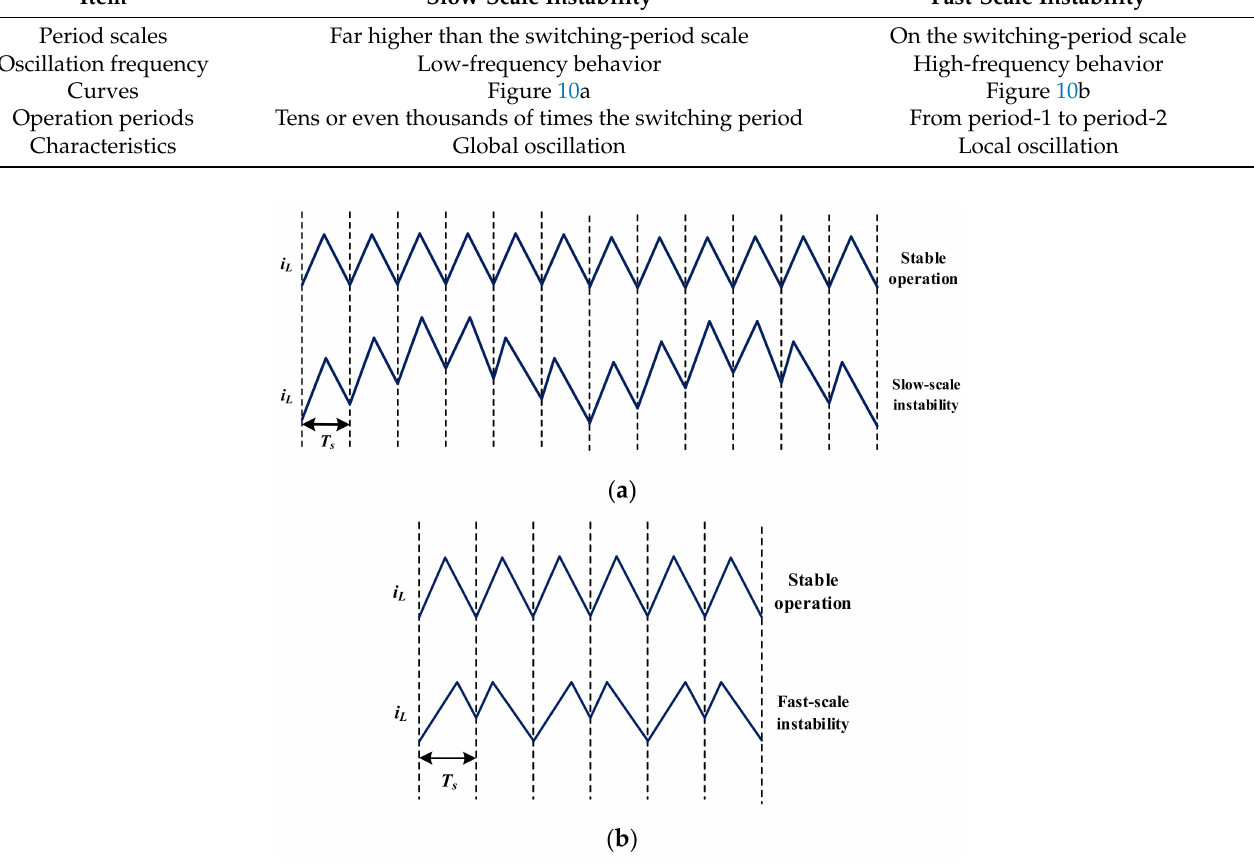
Figure 10. Characteristic curve of the instabilities. ( a ) Slow-scale instability and ( b ) fast-scale